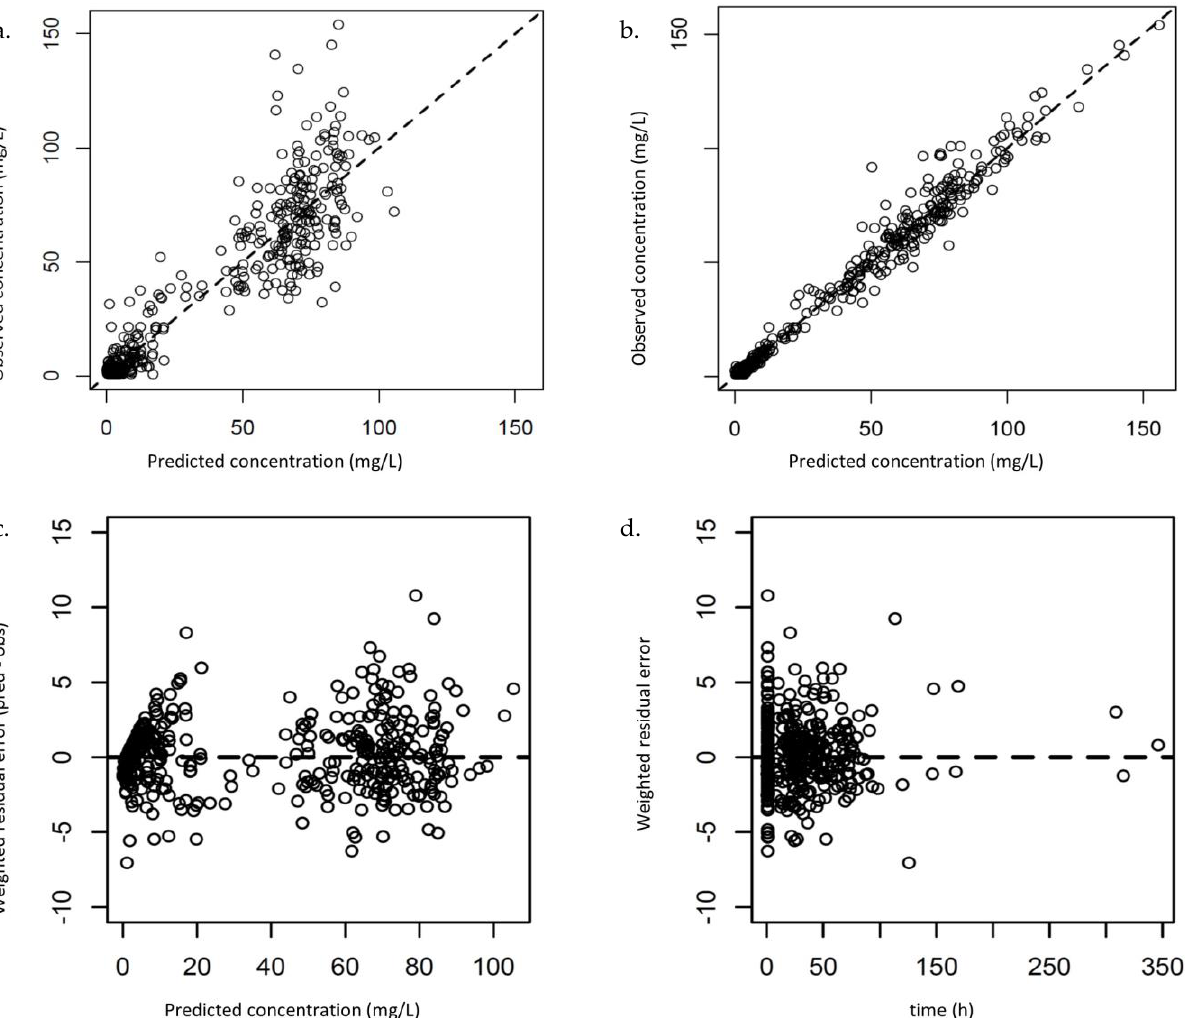
Figure 2. Diagnostic plots. Observed versus population-predicted amikacin concentrations ( a ) and individual-predicted amikacin concentrations ( b ). Weighted residual error plotted against predicted concentrations ( c ) and time ( d ) for population predictions. pred: predictions; obs: observa- tions .